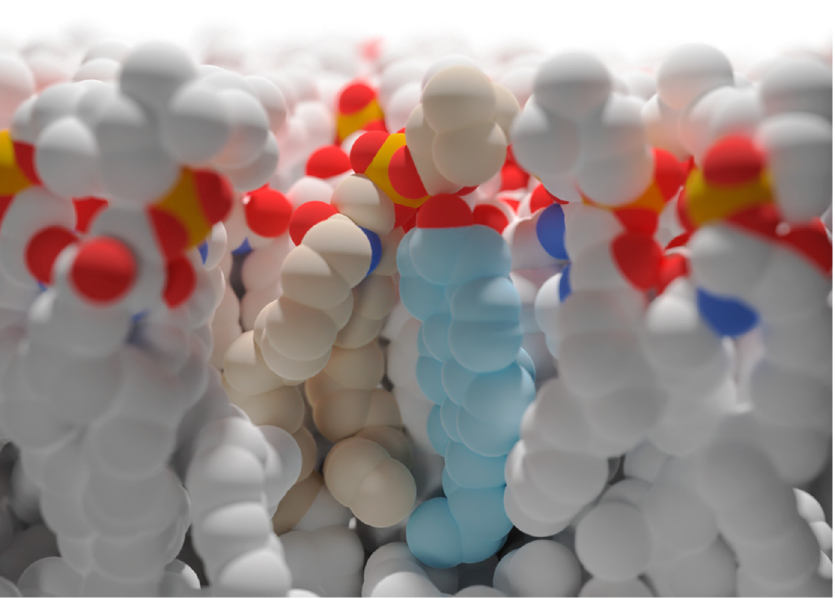
Figure 3. Artistic representation of the umbrella hypothesis. According to this hypothesis, Chol (in light blue) would be shielded from the solvent by the headgroup of neighboring SM molecules, such as the one in tan in the figure. For actinoporins, this could result in an easier recognition of SM. This figure was generated using UCSF Chimera, UCSF ChimeraX (https://www.cgl.ucsf.edu/chimerax/docs/credits.html), and composed and rendered in Blender (Community, B. O. (2018). Blender—a 3D modelling and rendering package. Stichting Blender Foundation, Amsterdam. Retrieved from http://www.blender.org).